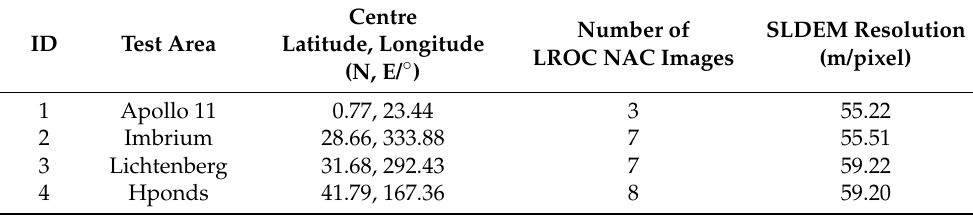
Table 1. Information of the four test